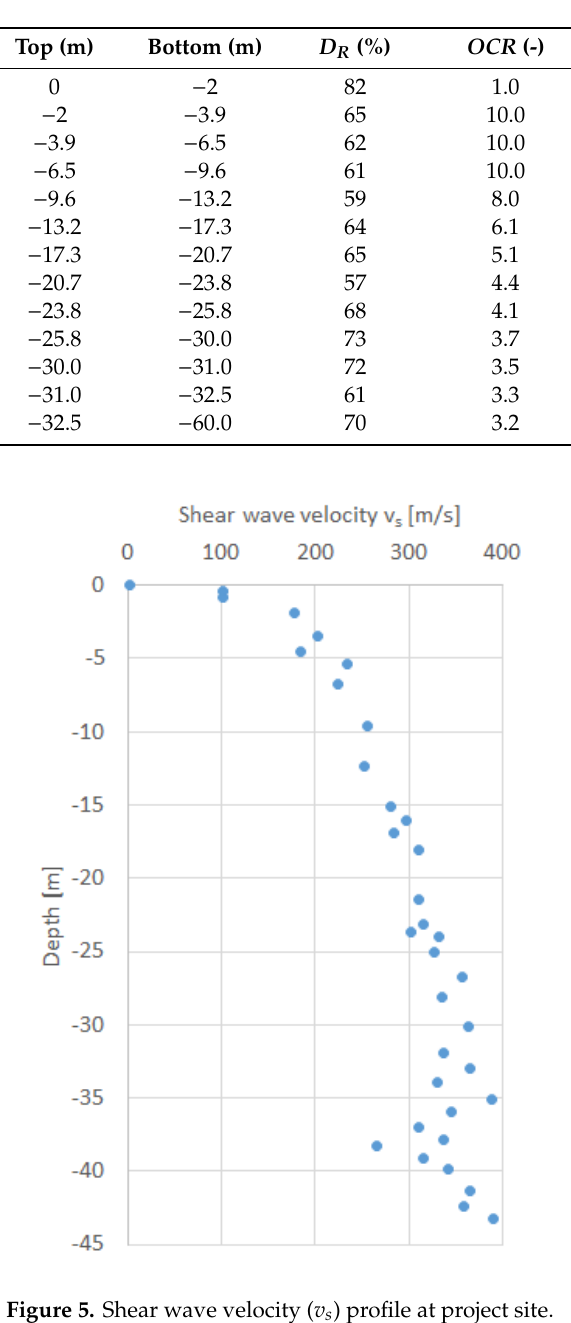
Table 4. Soil strata and corresponding relative density ( D R ) and over-consolidation ratio ( OCR ) at the project site.